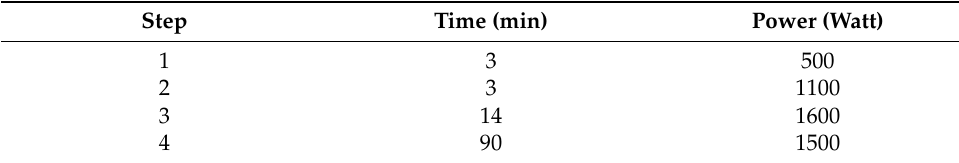
Table 2. Mild irradiation MAHD